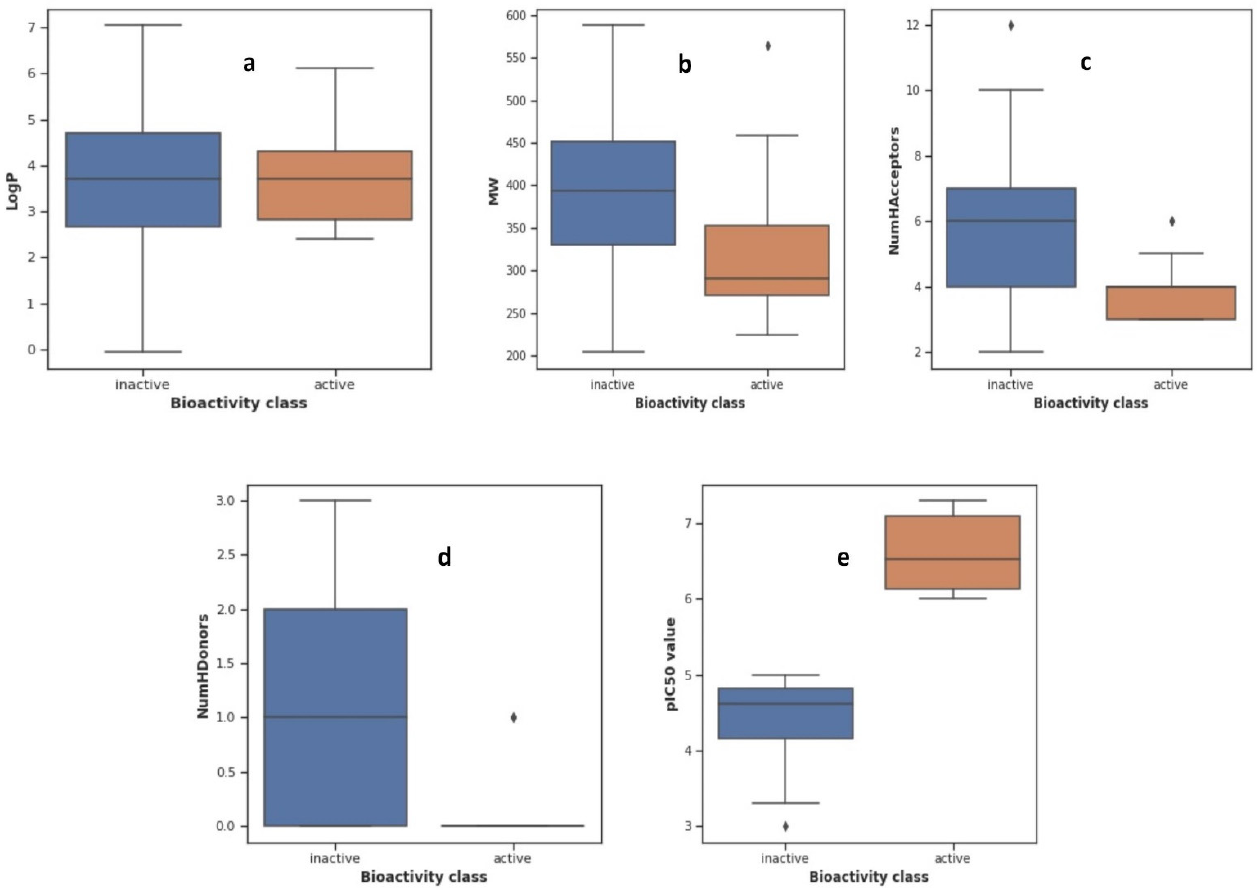
Figure 2. ( a – e ): Mann–Whitney U test for LogP, MW, NumHacceptors, NumHdonors, and pIC50. According to the analysis of the box plots, the margins of the boxes indicated that there was a negligible difference between both bioactivity classes for LogP. However, the MW, NumHAcceptors, NumHDonors, and pIC50 box plots revealed a clear difference between both